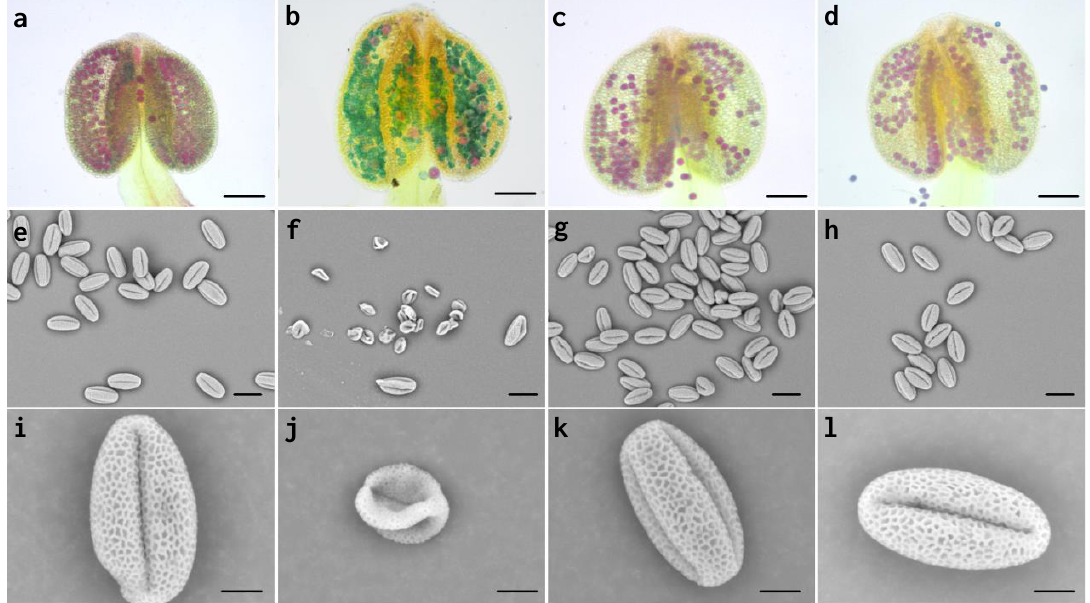
Figure 4. Morphological observation of pollen grains of Bra-MIR319 family overexpressing transgenic Arabidopsis . ( a – d ) Alexander staining of anthers of wild-type and Bra-MIR319 family transgenic Arabidopsis , respectively. ( e , i ) SEM observation of mature pollen grains of wild-type plants, ( f , j ) Bra-MIR319a transgenic plants, ( g , k ) Bra-MIR319b transgenic plants, and ( h , l ) Bra-MIR319c transgenic plants. Scale bars, 25 μm in ( a – h ), 50 μm in ( i – l ).